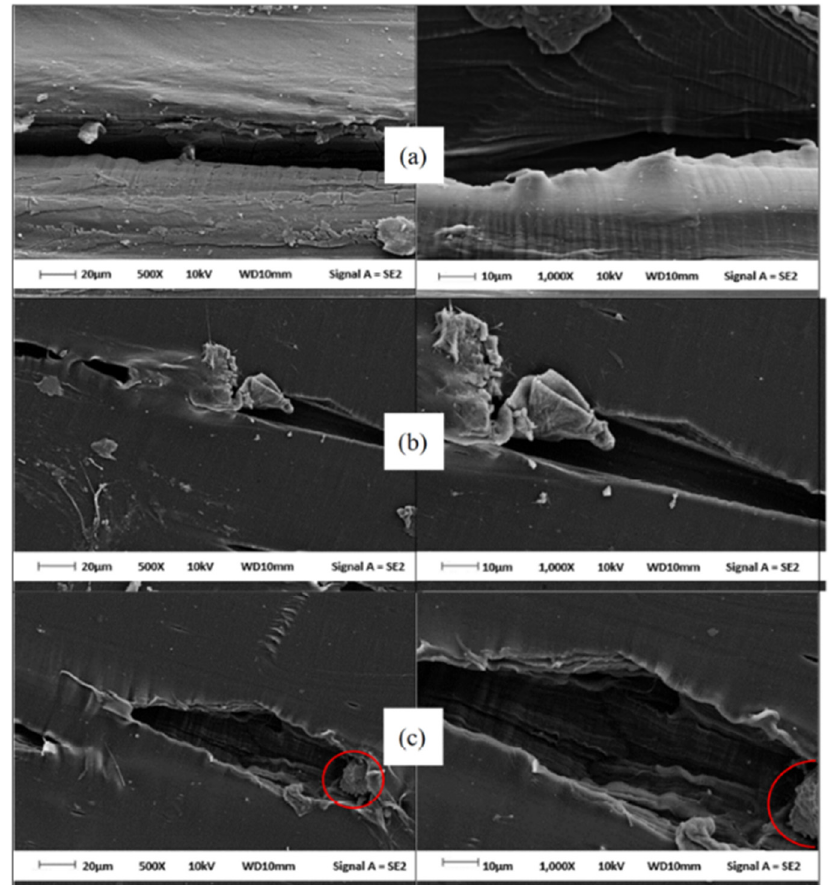
Figure 12. The FESEM images of the tensile fracture surface of the ( a ) virgin PECoVA, ( b ) PECoVA/DOL 3, and ( c ) PECoVA/OMCD 3 composite at 500 × magnification ( left ) and 1000 × magnification ( right ). Reprinted with permission from Ref. [13].